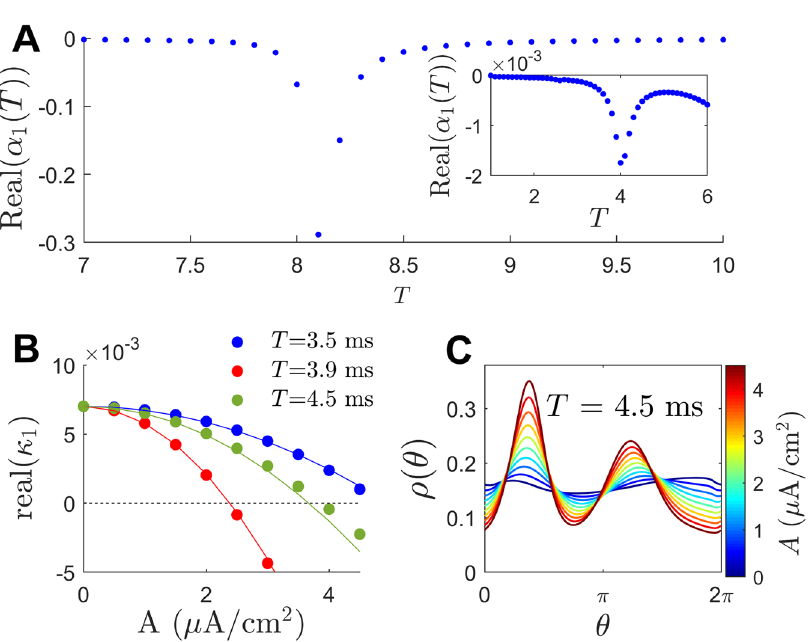
Figure 2. Behavior of unstable solutions of the Fokker-Planck equation (8) with sinusoidal forcing. Panel A shows a plot of Real( α 1 ( T )) which characterizes the ability of sinusoidal stimulation to modify the stability of the desynchronized unstable fixed point of (8). Two pronounced minima appear for stimulation periods of 8.1 and 4.0. Panel B compares the predicted (solid lines) and actual (colored dots) Floquet exponents for various combinations of stimulation frequency and amplitude. Panel C shows snapshots of the resulting periodic orbits induced by sinusoidal forcing with a period of 4.5 milliseconds. A bimodal distribution emerges that becomes more pronounced as the amplitude of forcing increases. Periodic orbits obtained using A ≤ 3.5 μ A /cm 2 are unstable, the remaining orbits are